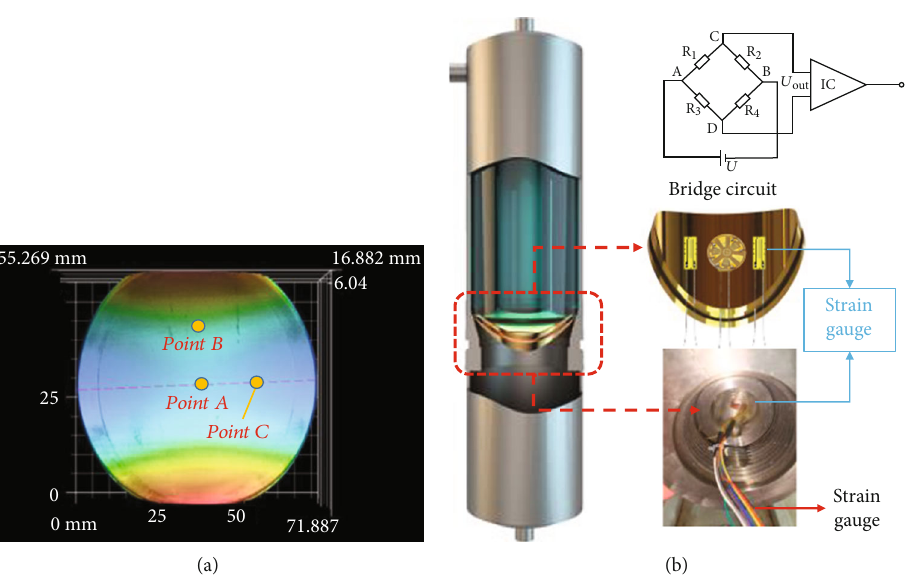
Figure 15: Deformation and failure pressure test. (a) 3D pro fi le scanning analysis. (b) Test system of the pressure-maintaining